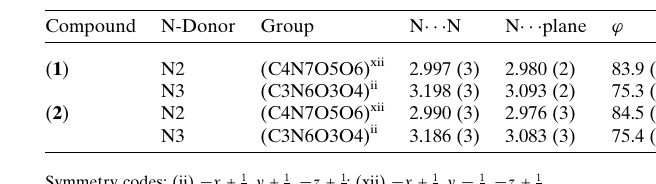
, y + 1 , z ; (v) (cid:3) x + 1, y + 1, 2 2